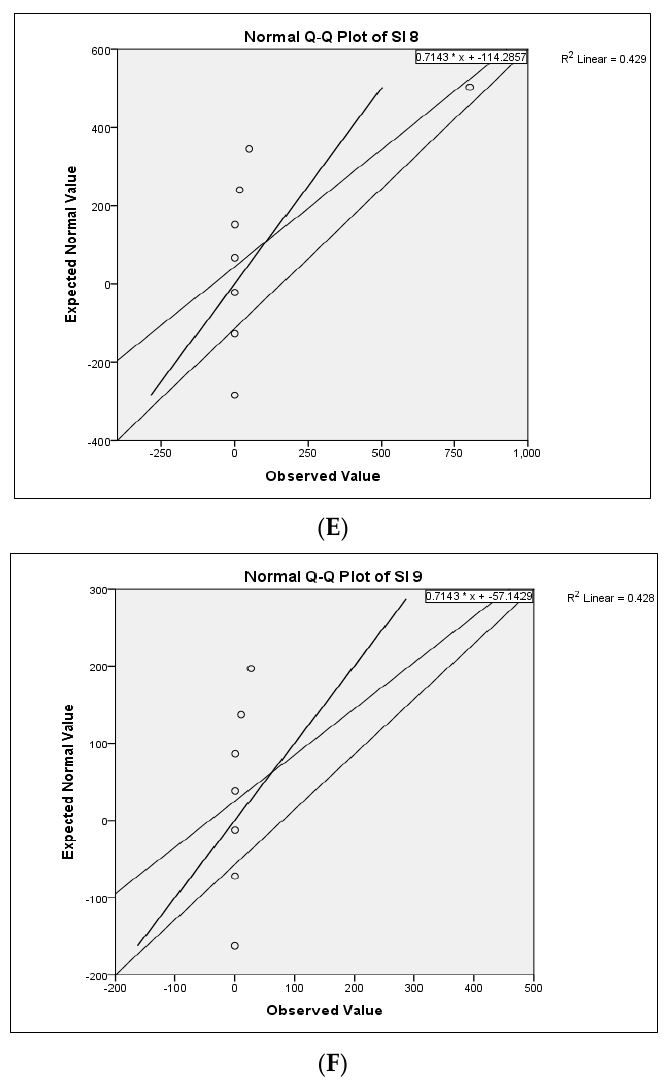
Figure 7. Normal Q–Q plot of soil salinity and soil salinity indices: ( A ) = EC e (dSm − 1 ); ( B ) = SI 1; ( C ) = SI2; ( D ) = SI 7; ( E ) = SI 8 and ( F ) = SI 9. Table 6. Soil salinity values prediction and